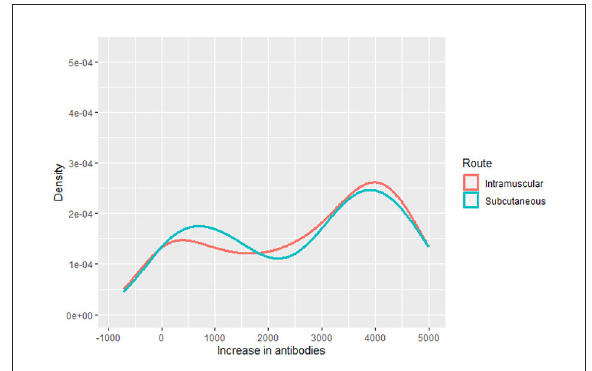
FIGURE2 Density functions of increase in antibodies by